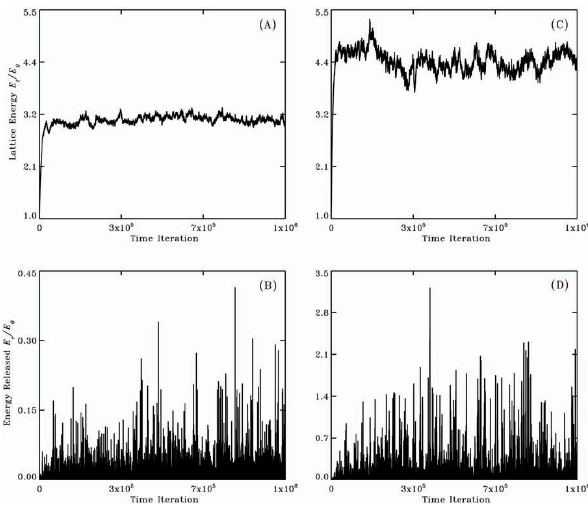
Fig. 2. Time series of total lattice energy and energy released in avalanches in a 64 × 64 node lattice with stability threshold angle 2 c =2 rad. On the left side amplitudes combination was δ + = 1 and δ − =− 1, corresponding to symmetrical driving displacements, and on the right δ + = 3 and δ − = − 1, yielding asymmetrical driving. Note the different vertical scales between panels (B) and (D) .